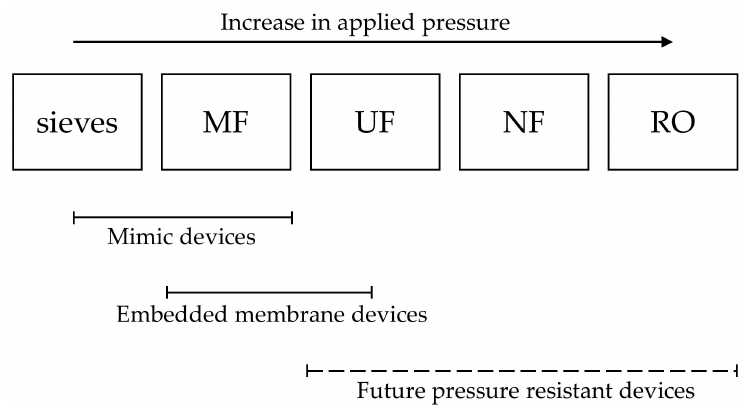
Figure 3. Scheme showing which type of microfluidic devices are currently suitable for the study of di ff erentporousmedia—sieves, microfiltration(MF),ultrafiltration(UF),nanofiltration(NF),andreverse osmosis